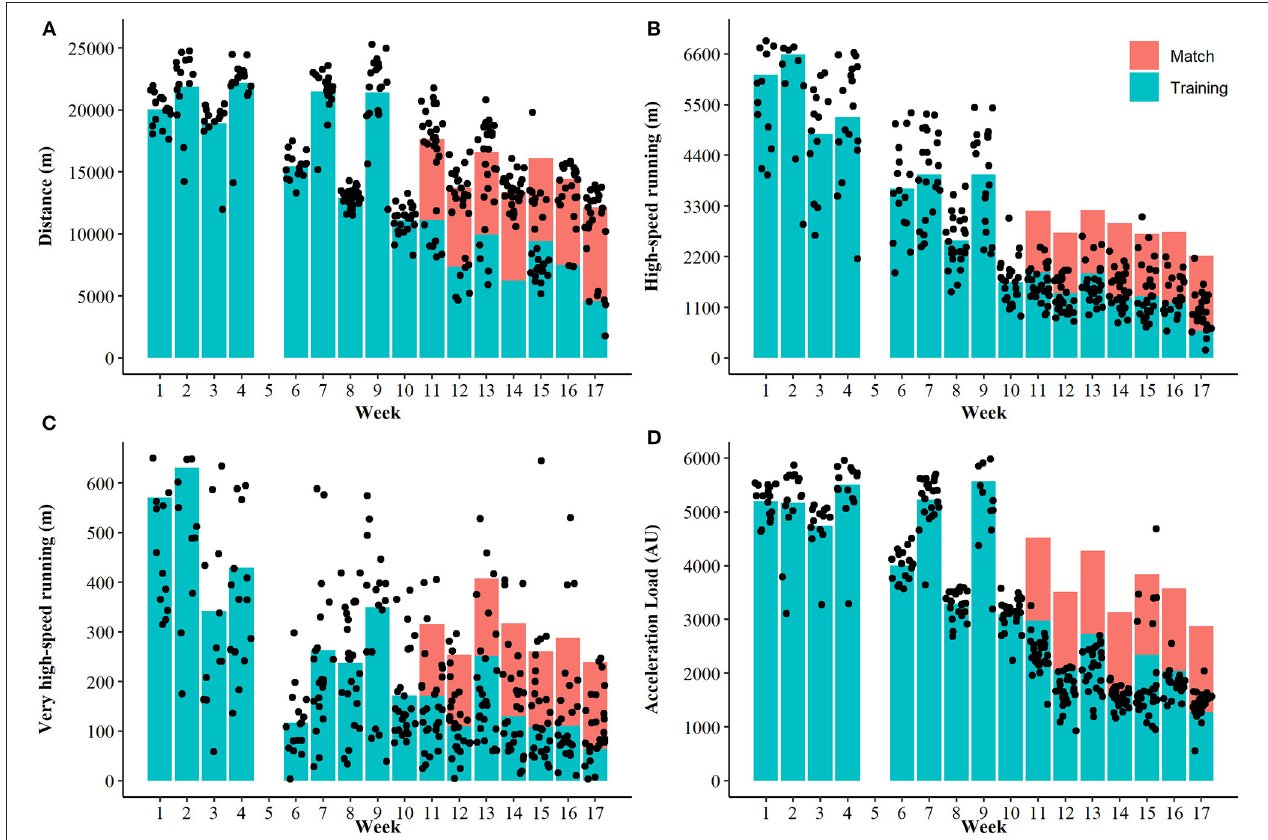
FIGURE 2 | Mean (bars) and individual (dots) weekly physical demands of training and matches across the pre-season and in-season phases. The pre-season phase was week 1–10 (general preparation was weeks 1–4, specific preparation weeks 6–10), and competition was weeks 11–17 for (A) distance, (B) high-speed running, (C) very high speed running, and (D) acceleration load. *high-speed running is > 14.4 km · h − 1 and very-high speed running is > 20 km · h − 1